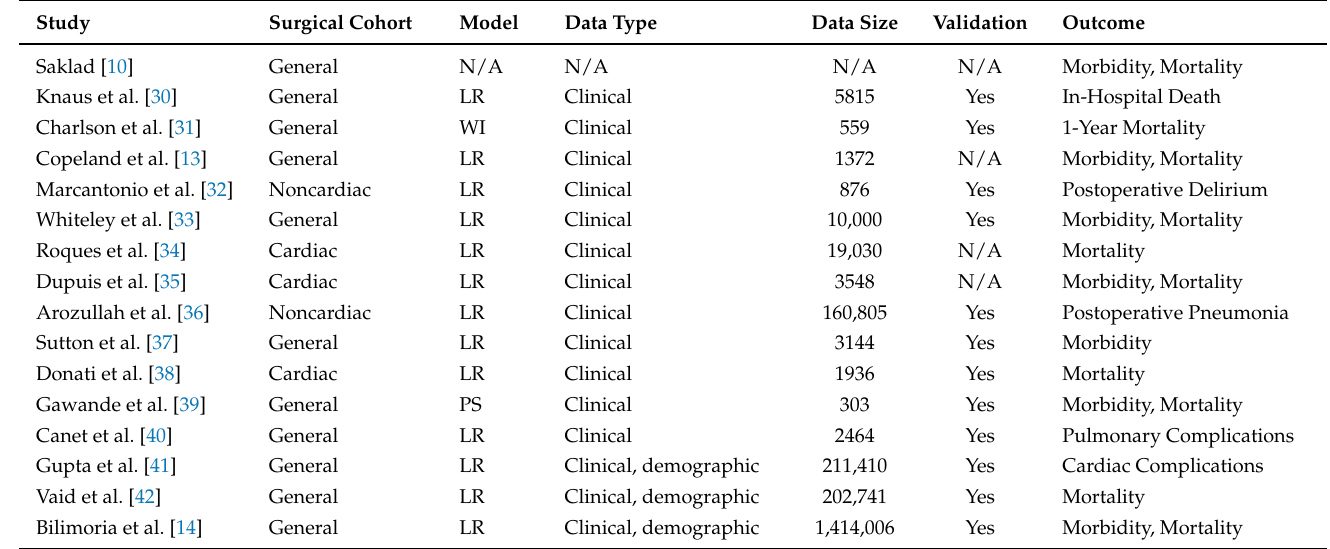
Table 1. Compilation of traditional statistical studies in postoperative prognostics according to the major taxonomic dimensions (literature references in chronological